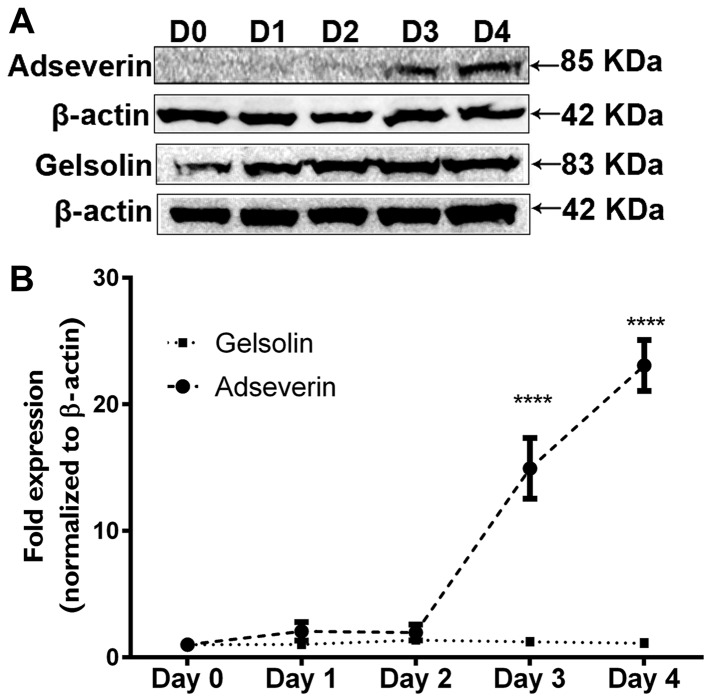
Expression of adseverin (Ads) and gelsolin in Ads-knockdown RAW264.7 cells and RAW264.7 cells stimulated with sRANKL for 4 days. (A) Expression of Ads, gelsolin, and β-actin in RAW264.7 cells on days 0, 1, 2, 3 and 4 after RANKL stimulation using western blot analyses. (B) Protein expression levels of Ads and gelsolin were analyzed by western blotting. β-actin was used as a loading control. Band values were quantified by densitometric analyses. Gelsolin was expressed at similar levels on days 0, 1, 2, 3 and 4. However, Ads expression increased after day 3. RANKL, receptor activator of nuclear factor-κB ligand.